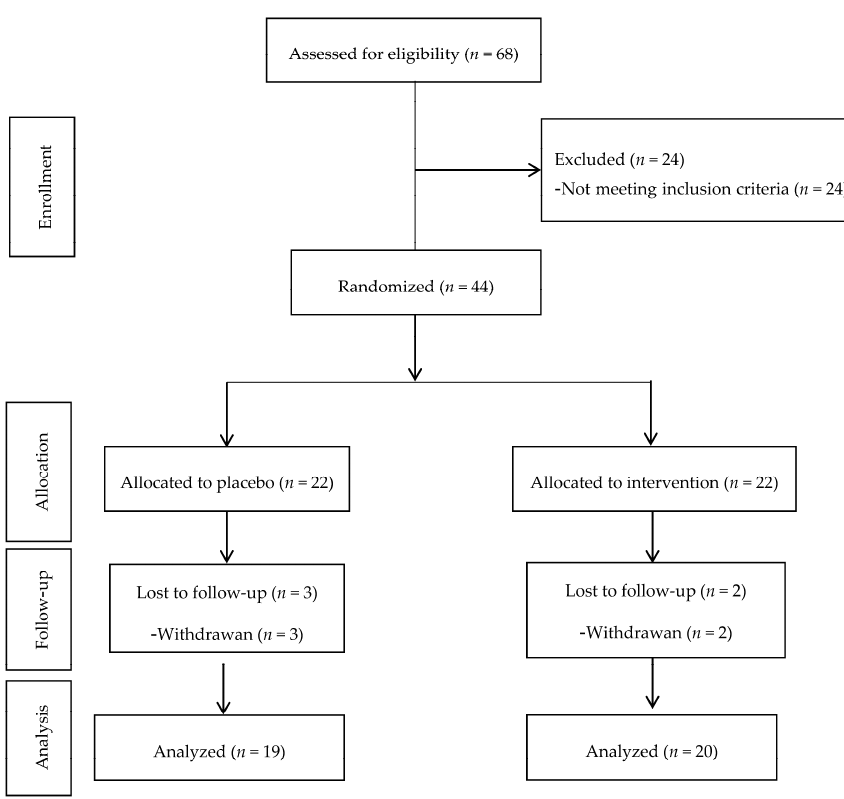
Figure 1. Summary of patient flow chart.